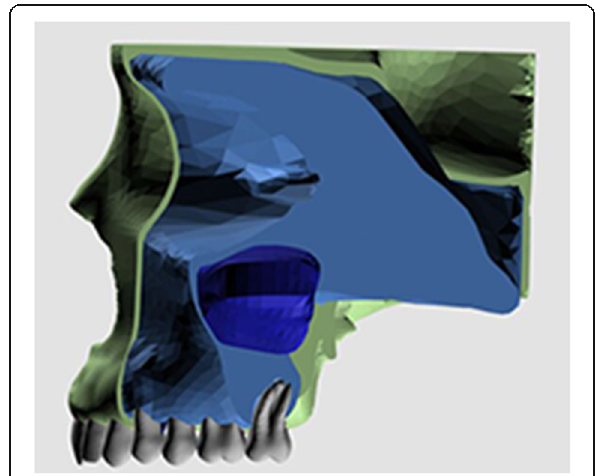
Fig. 1 Cortical bone layer, spongious bone, maxillary sinus, and teeth from the sagittal view